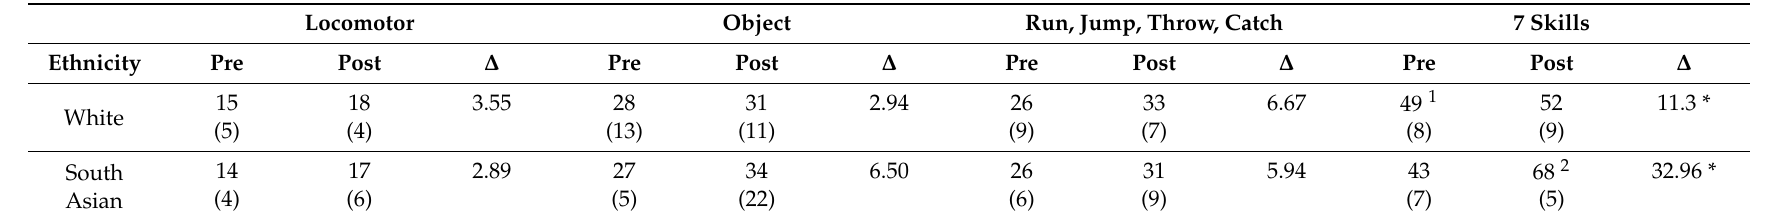
Table 3. Overall skills pre vs. post: mean (SD).